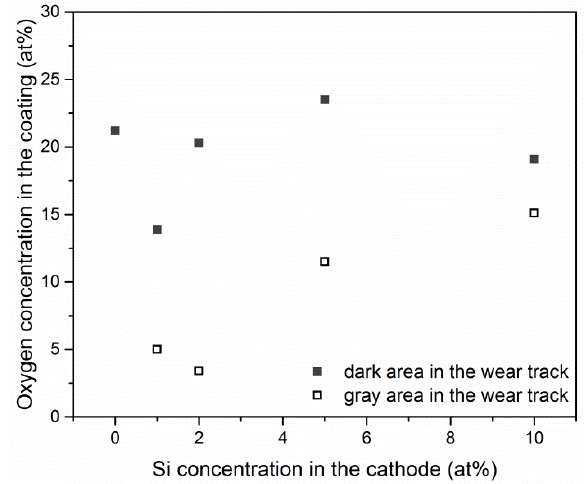
Figure 11. Oxygen concentrations in the dark and gray areas of AlCrSiN coatings deposited from cathodes with various silicon concentrations.